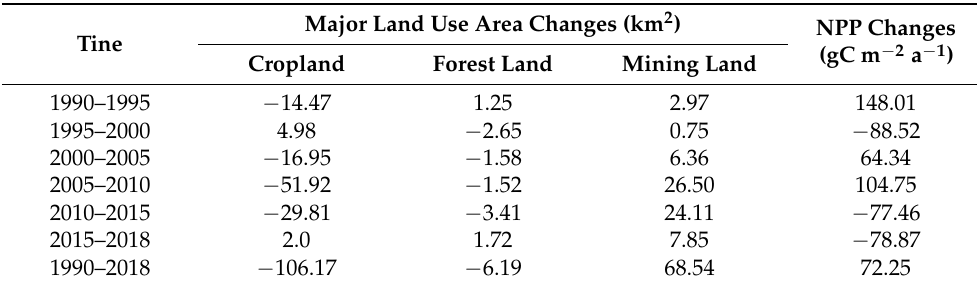
Table 5. Change of land use area and NPP from 1990 to 2018. Tine